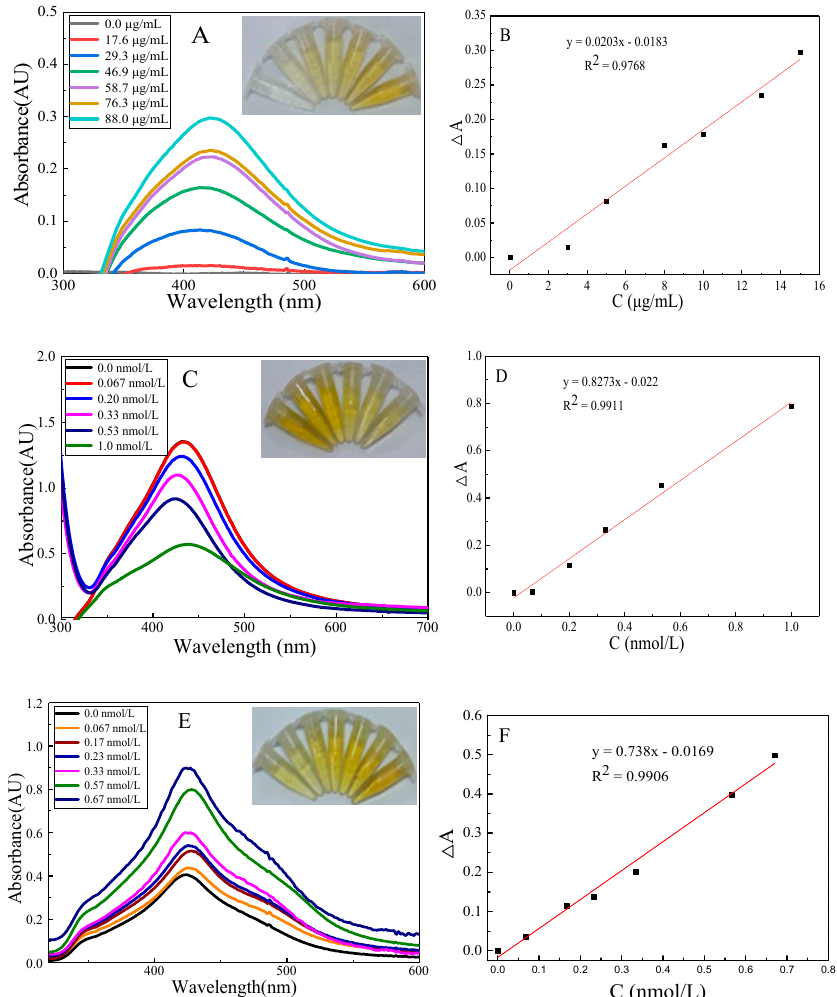
Figure 2. The absorption spectra of the system and their corresponding linear relationship. ( A , B ) AgCOF catalytic system: (0, 17.6, 29.3, 46.9, 58.7, 76.3, 88.0) μ g/mL AgCOF+ 0.87 mmol/L AgNO 3 + 6.67 mmol/L TC. ( C , D ) Aptamer inhibition system: (0, 0.067, 0.20, 0.33, 0.53, 1.0) nmol/L Pb 2+ Apt+ 88.0 µ g/mL AgCOF+ 0.867 mmol/L AgNO 3 + 6.67 mmol/L TC. ( E , F ) Pb 2+ determination system: (0, 0.067, 0.17, 0.23, 0.33, 0.57, 0.67) nmol/L Pb 2+ + 1.0 nmol/L Pb 2+ Apt + 88.0 µ g/mL AgCOF